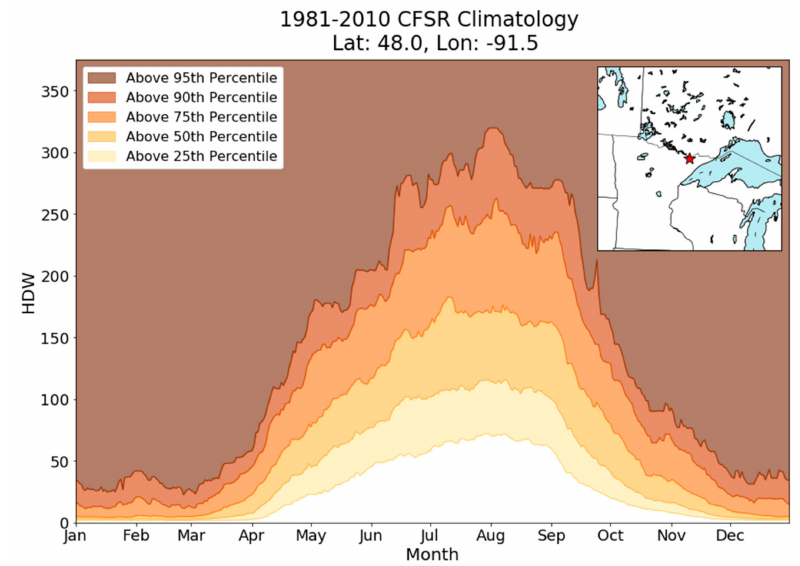
Figure 1. Centered, 15-day running HDW climatological percentiles per day (shaded) calculated using CFSR data from 1981 to 2010 for the grid point at 48.0 ◦ N, 91.5 ◦ W. Map inset shows grid point location with a red